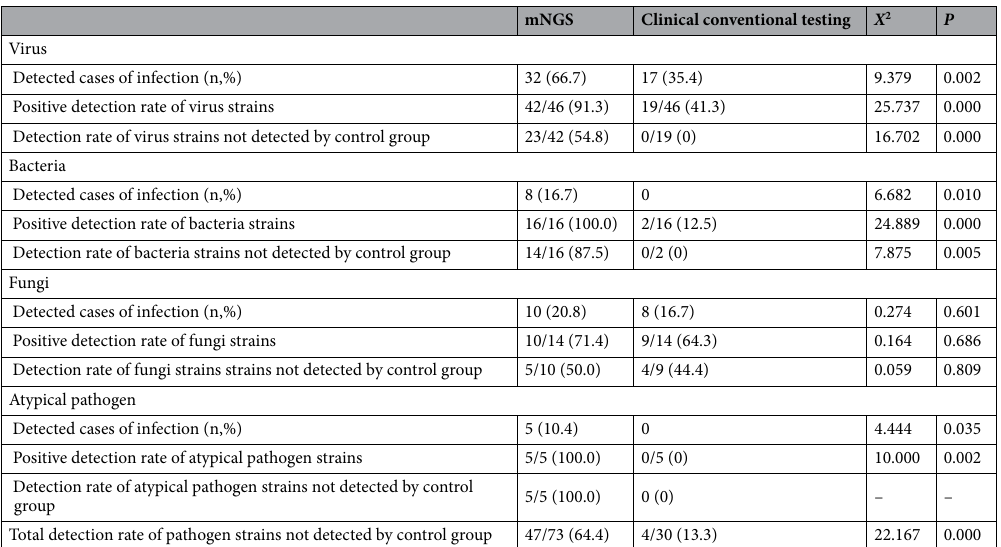
Table 2. Detection efficiency comparison of various pathogens by mNGS and clinical conventional